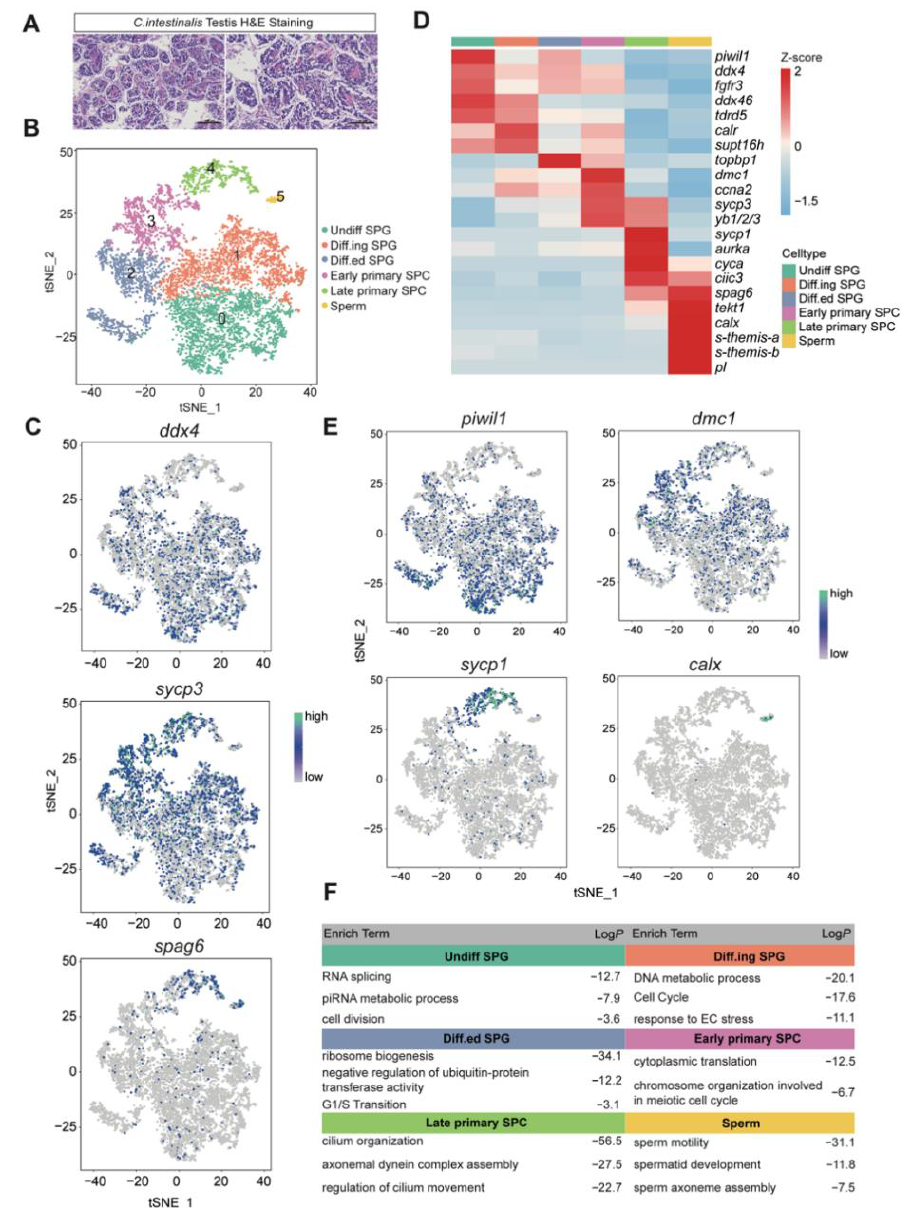
Figure 1. Single-cell transcriptome analysis identified germ cells of C. intestinalis testis . ( A ) Histological and morphology of C. intestinalis testes by H&E staining. Left: scale bar = 100 µm; right: scale bar = 50 µm. ( B ) t-SNE and clustering analysis of scRNA-seq data from C. intestinalis testis germ cells (n = 6832). Different cell types are shown in distinct colors. The 6 cluster identities were assigned based on marker gene expression shown in Figure 1C – E. Undiff SPG: undifferentiated spermatogonia; Diff.ing SPG: differentiating spermatogonia; Diff.ed SPG: differentiated SPG; SPC: spermatocyte. ( C ) t-SNE plot showing the expression of genes ddx4 , sycp3 and spag6 . ( D ) Heatmap showing the expression of marker genes in different cell types. Differential gene-expression levels utilize a Z score, which represents the variance from the mean, as defined in the color key in the top-right corner. ( E ) t-SNE plot showing the expression of major marker genes. ( F ) Enriched terms for DEGs are shown for germ-cell types ( p values are shown).